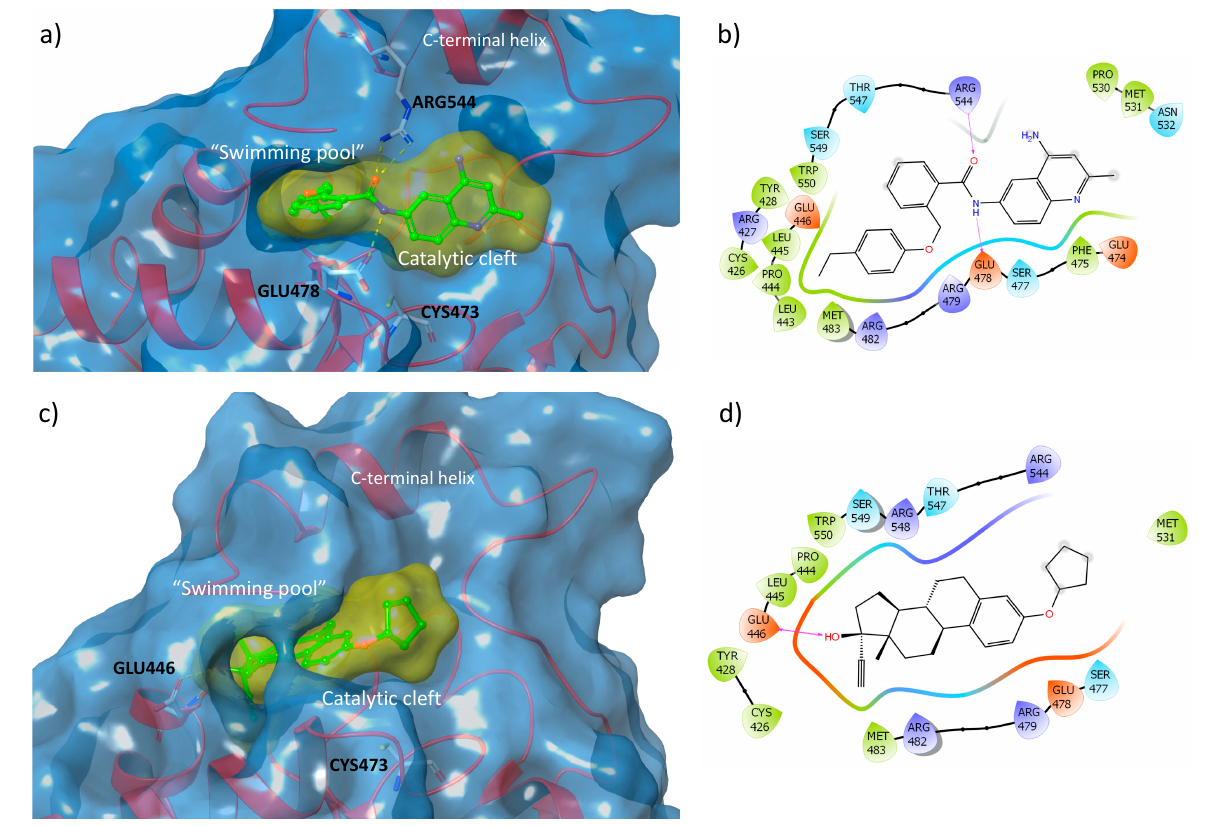
Figure 11. Predicted binding modes of J3955 ( a ) and of E7887 ( c ) into the “swimming pool”-catalytic cleft of Cdc25B (PDB id: 1QB0); ligand–protein interaction diagram for J3955–Cdc25B ( b ) and E7887–Cdc25B ( d ) complexes, with the hydrogen bond shown as violet arrows.